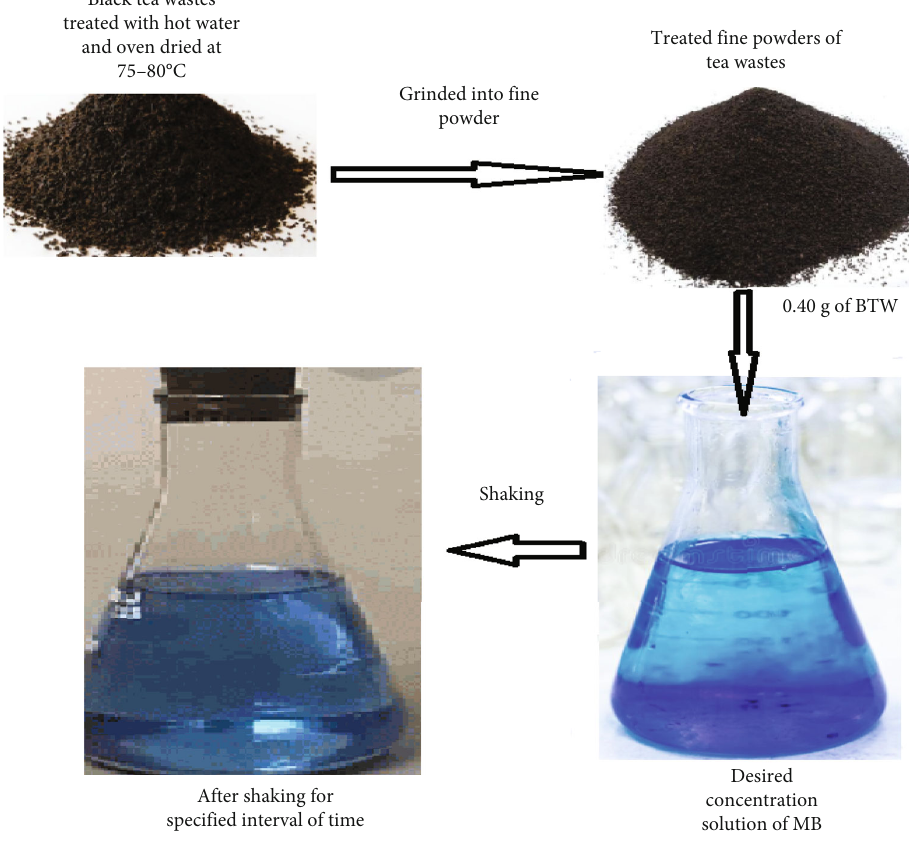
Figure 1: Schematic representation of decolorization of M.B by BTW.